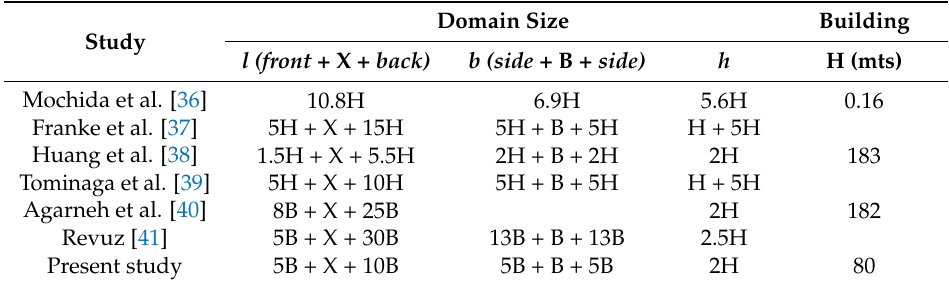
Table 1. Domain sizes from relevant tall building computational fluid dynamics (CFD) simulation.